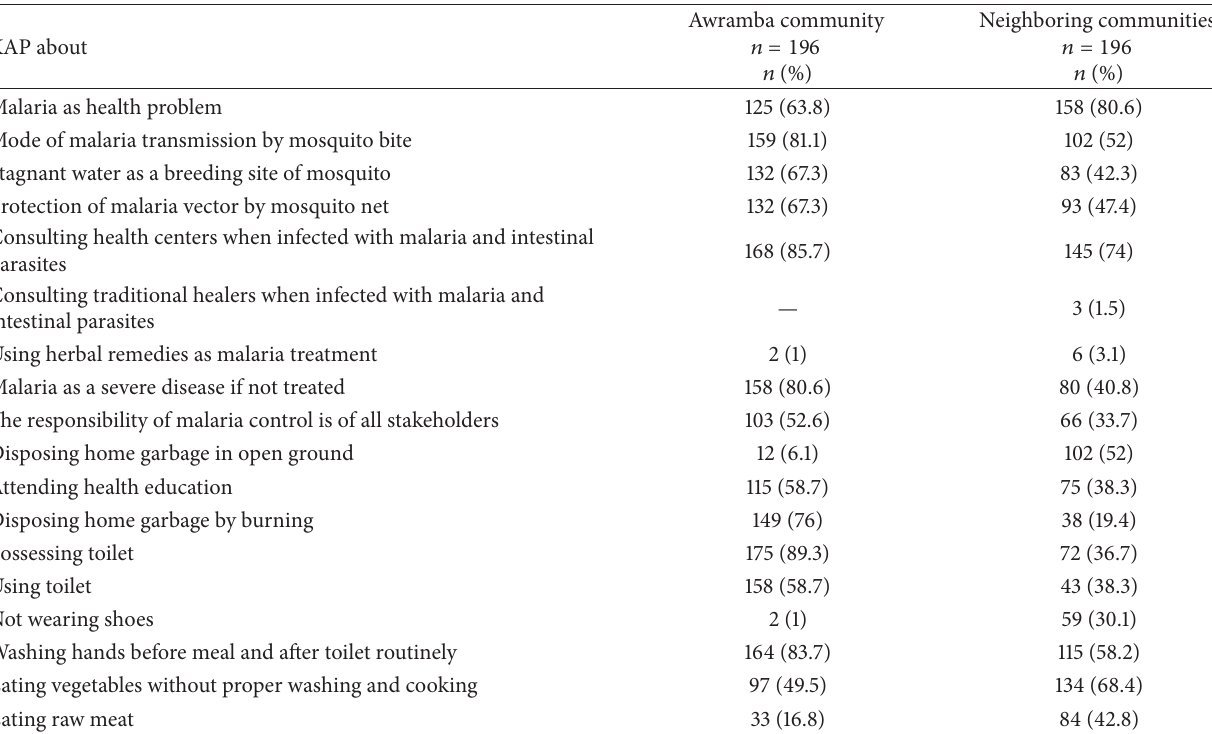
Table 4: Knowledge, attitude, and practice on malaria and intestinal parasites among Awramba and its neighboring communities in Fogera Woreda, South Gondar Zone, Ethiopia (November 2010–April